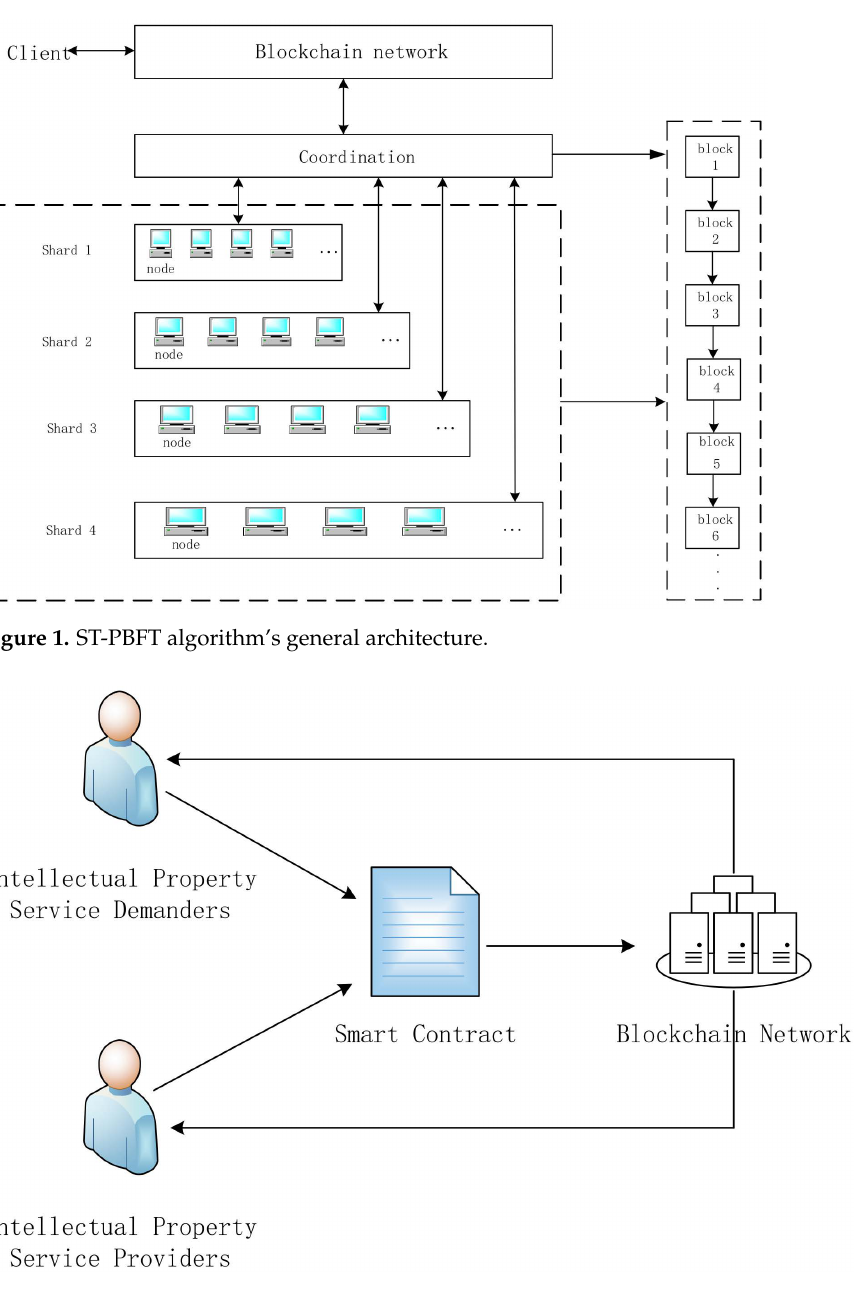
Figure 2. Intellectual property